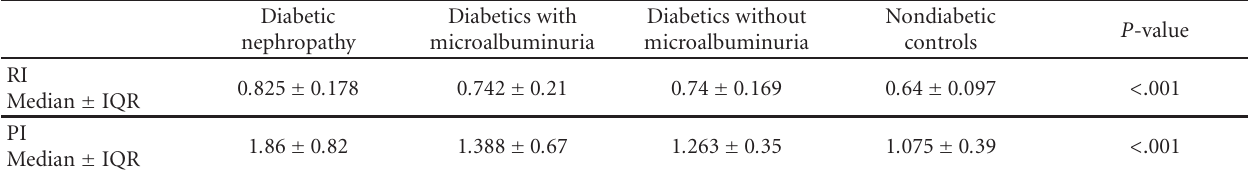
Table 2: Comparison of RI and PI between groups.